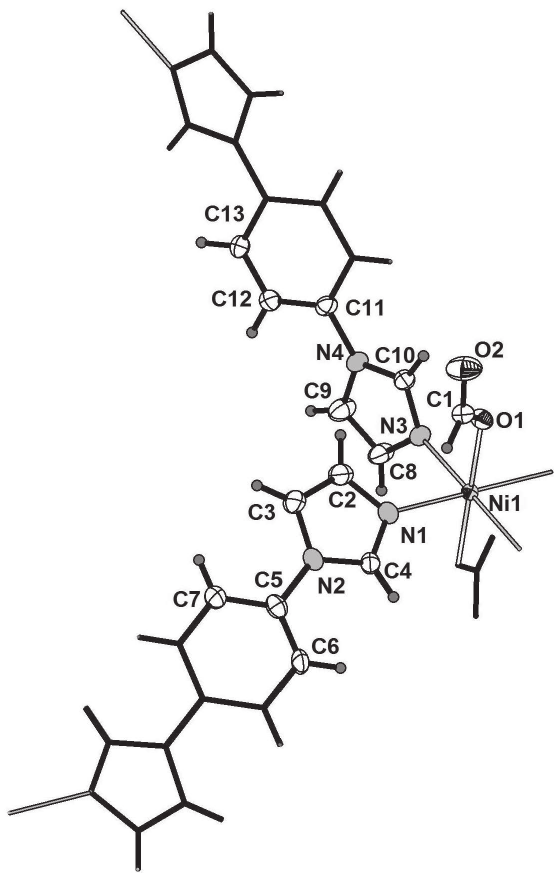
The asymmetric unit (50% ellipsoids) of the title structure is shown in the figure together with the adjacent symmetry re- lated moieties. Tables 1–3 contain details of the measurement method and a list of the atoms including atomic coordinates and displacement